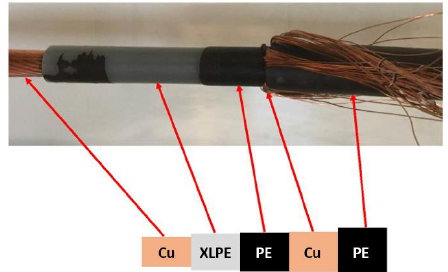
Figure 4. A representative copper (Cu) cable opened to show the layers of cross-linked polyethylene (XLPE) and polyethylene (PE) insulation, as presented in Table 1 [16].